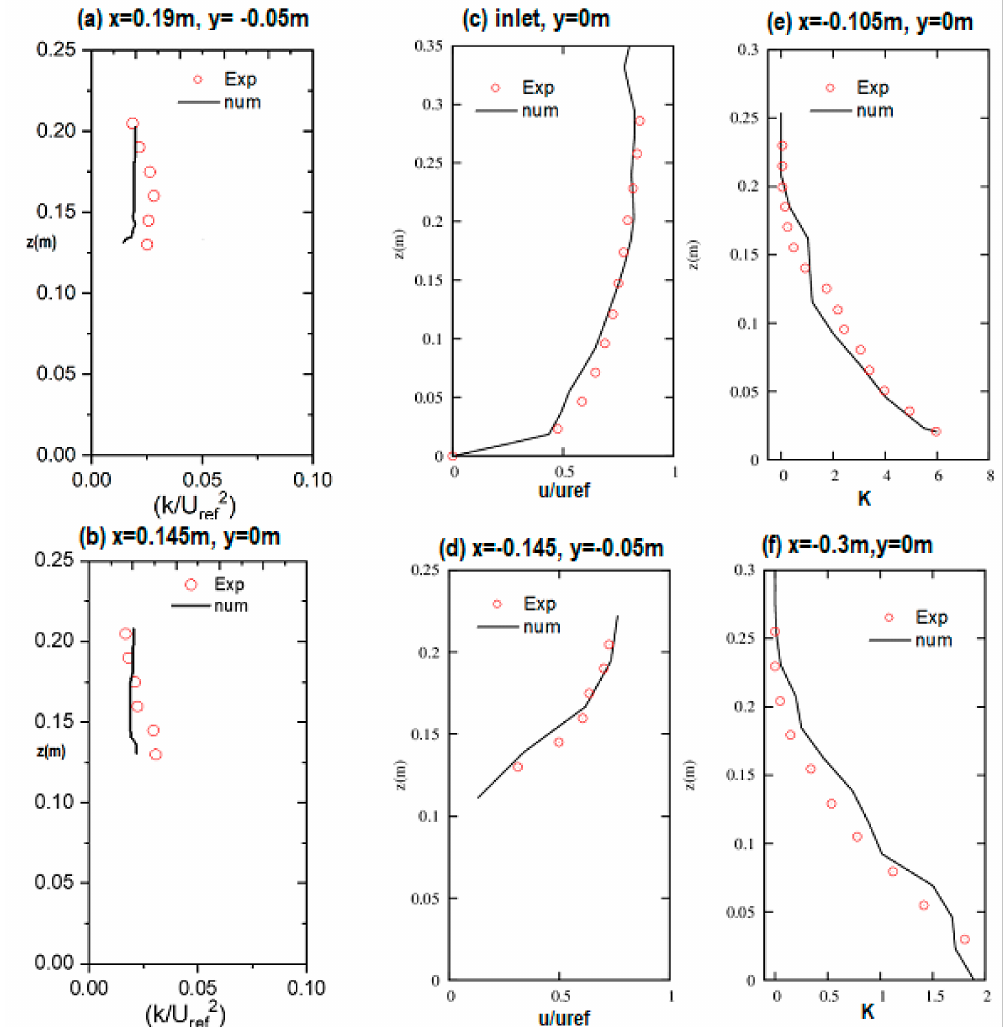
Figure 2. Comparison between the numerical and experimental results of the normalized turbulent kinetic energy ( a , b ), non-dimensional velocity ( c , d ), and dimensionless concentration ( e , f